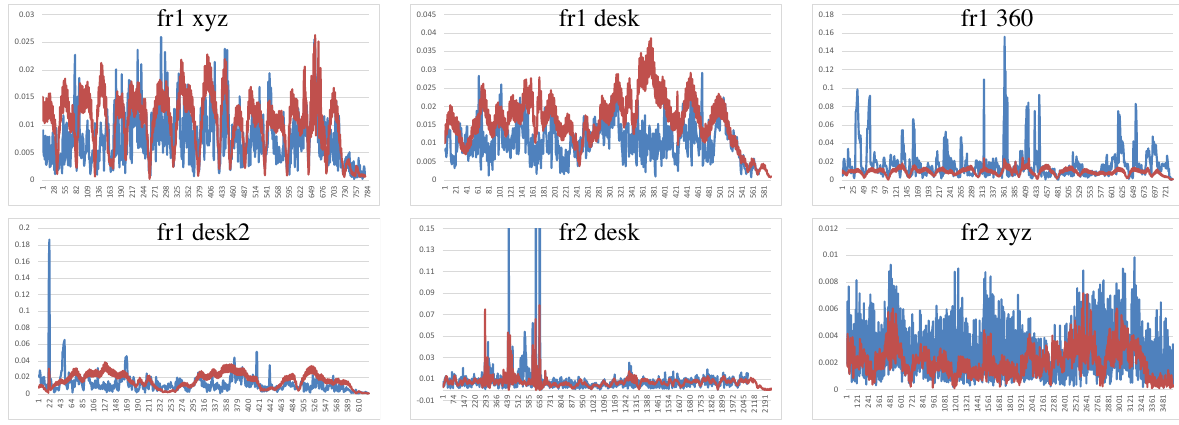
Figure 11. ICP relative pose translational errors (y-axis, meters) on the selected datasets over all the frames (x-axis,